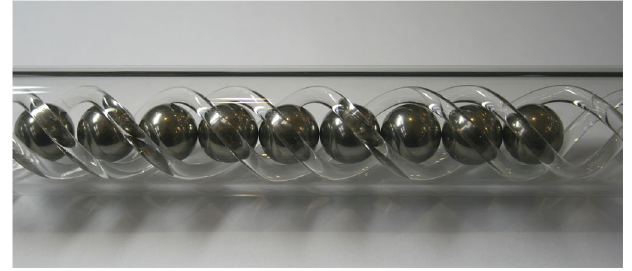
FIG. 3. Spherical array target for heat transfer tests.